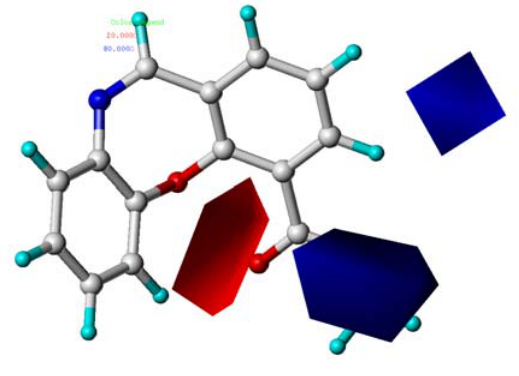
Figure 4. Contour maps of CoMFA electrostatic region in combination with compound 10 . Electrostatic fields: blue contours (80% contribution) represent regions where low electron density groups increase activity, while red contours (20% contribution) represent regions where high electron density groups increase activity. Compound 10 is depicted in ball and stick representation, coloured by atom type (white C, blue N, red O, cyan